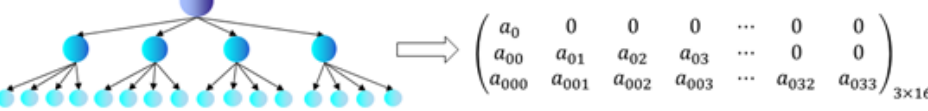
Figure 1. The process of initializing the pheromone matrix of the three-layer quadtree.